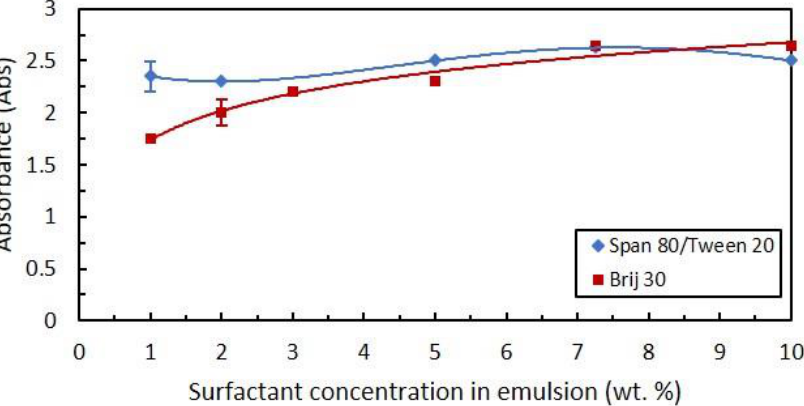
Figure 5. Effects of surfactant concentrations of either Span 80/Tween 20 or Brij 30 on absorbance value of emulsions.